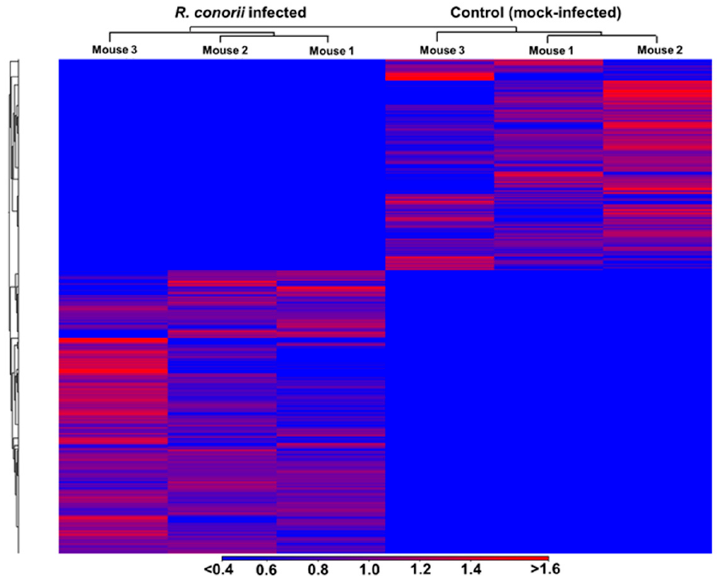
Figure 3. Hierarchical clustering of differentially expressed genes in the lungs of control and R. conorii -infected mice. Red color in the cluster indicates up-regulation and blue color in the cluster indicates down-regulation. The fold expression values presented below are in terms of log 2 .